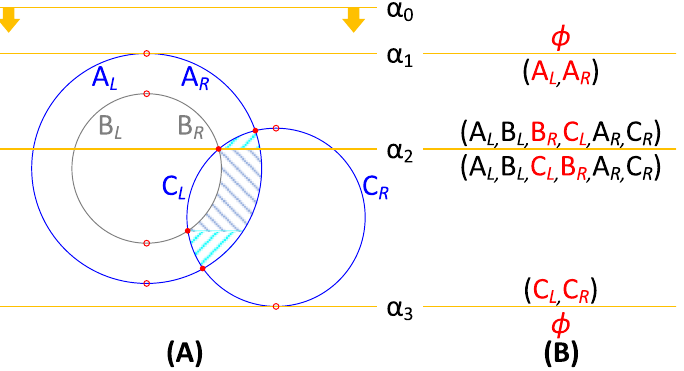
Fig 2. Illustration of how the sweep-line algorithm handles three different types of event points. (A) A cross- sectional plane that contains two solvent circles A and C , and one atom circle B . Small hollow (and filled) red circles represent circle-start and circle-end (and segment-intersection) event points. Three orange horizontal lines represent the sweep lines at the three different types of event points. Three light blue regions with hatch patterns show three solvent patches belonging to the cross-sectional area of the CSAV. (B) An illustration showing how the circle segments ( A L , A R , ... , C R ) are stored in a sorted list before (above the orange sweep line) and after (below) handling